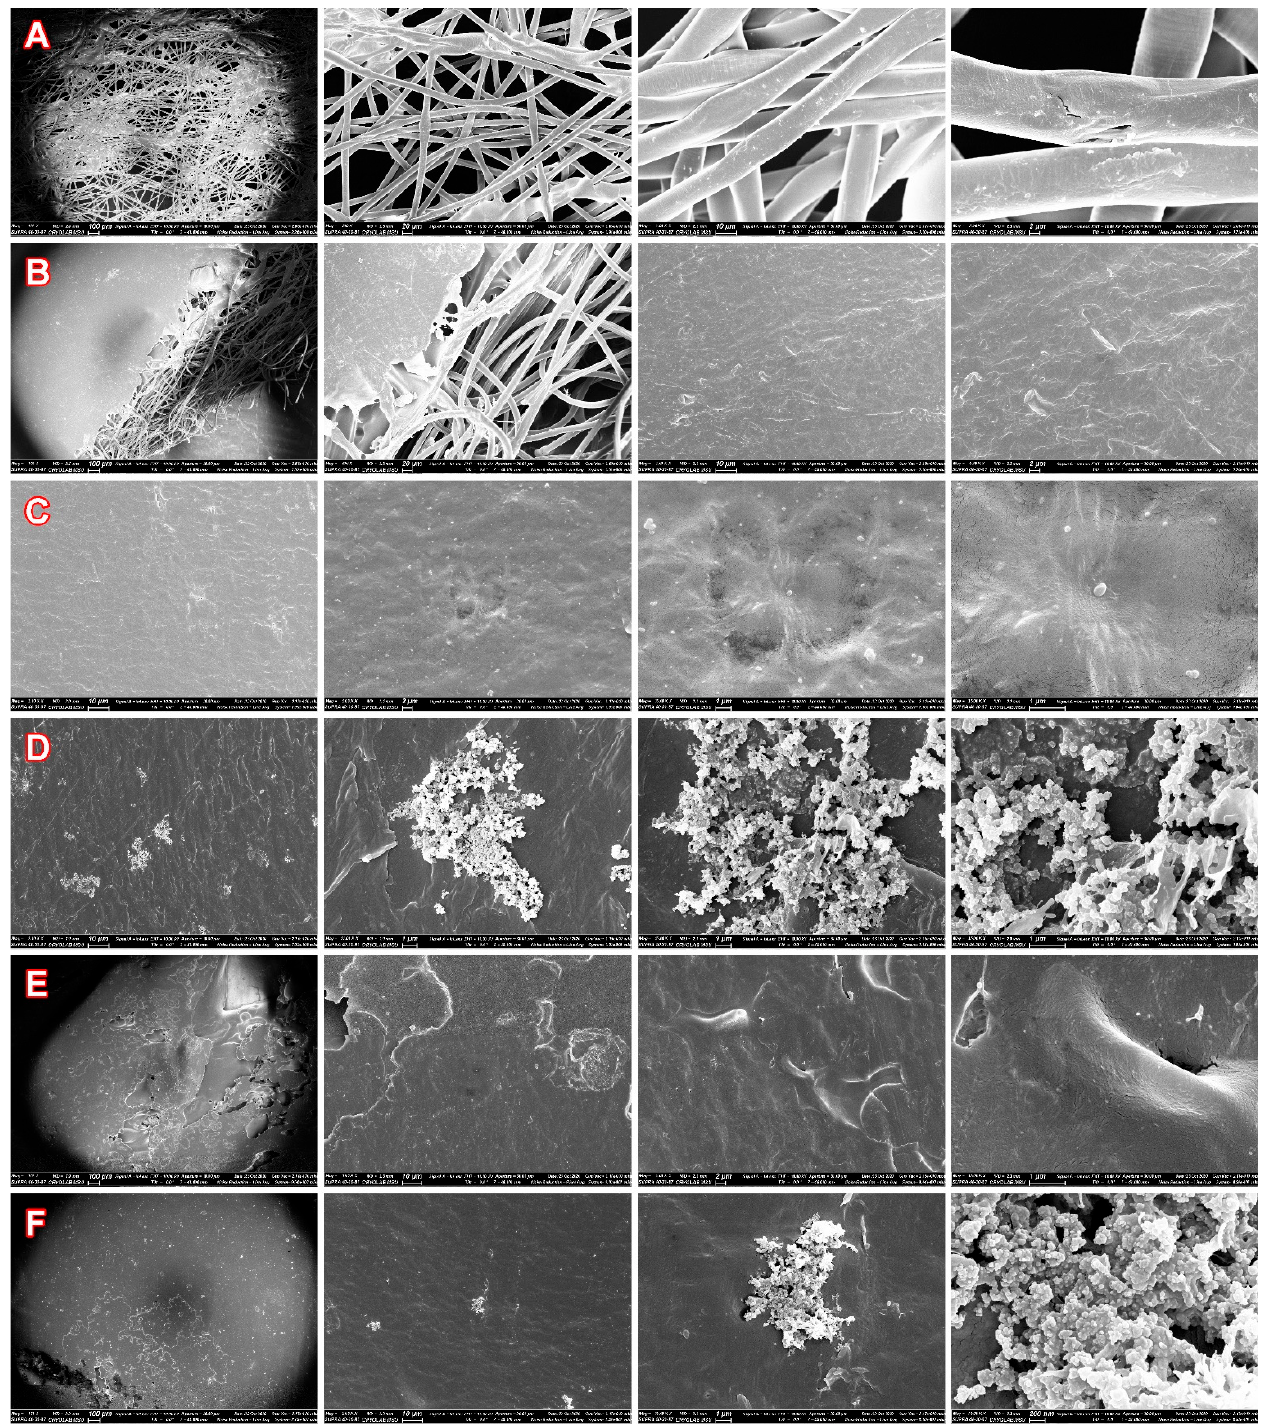
Figure 1. ( A ) SEM images of PLA(S). ( B ) SEM of FM modified by PCL. ( C ) SEM of BC modified by PCL. ( D ) SEM of BC modified by PCL and functionalized by Ta NPs in ethanol. ( E ) SEM of BC modified by PHB. ( F ) SEM of BC modified by PHB and functionalized by Ta NPs in ethanol.